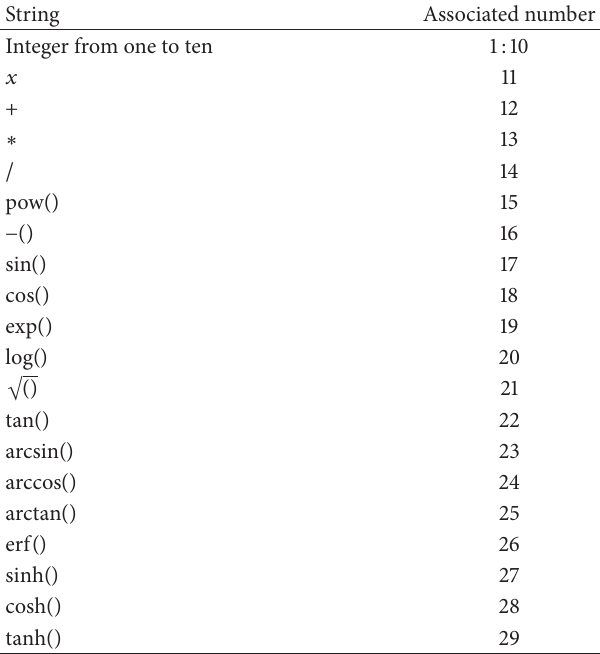
Table 1: Proposed grammar.